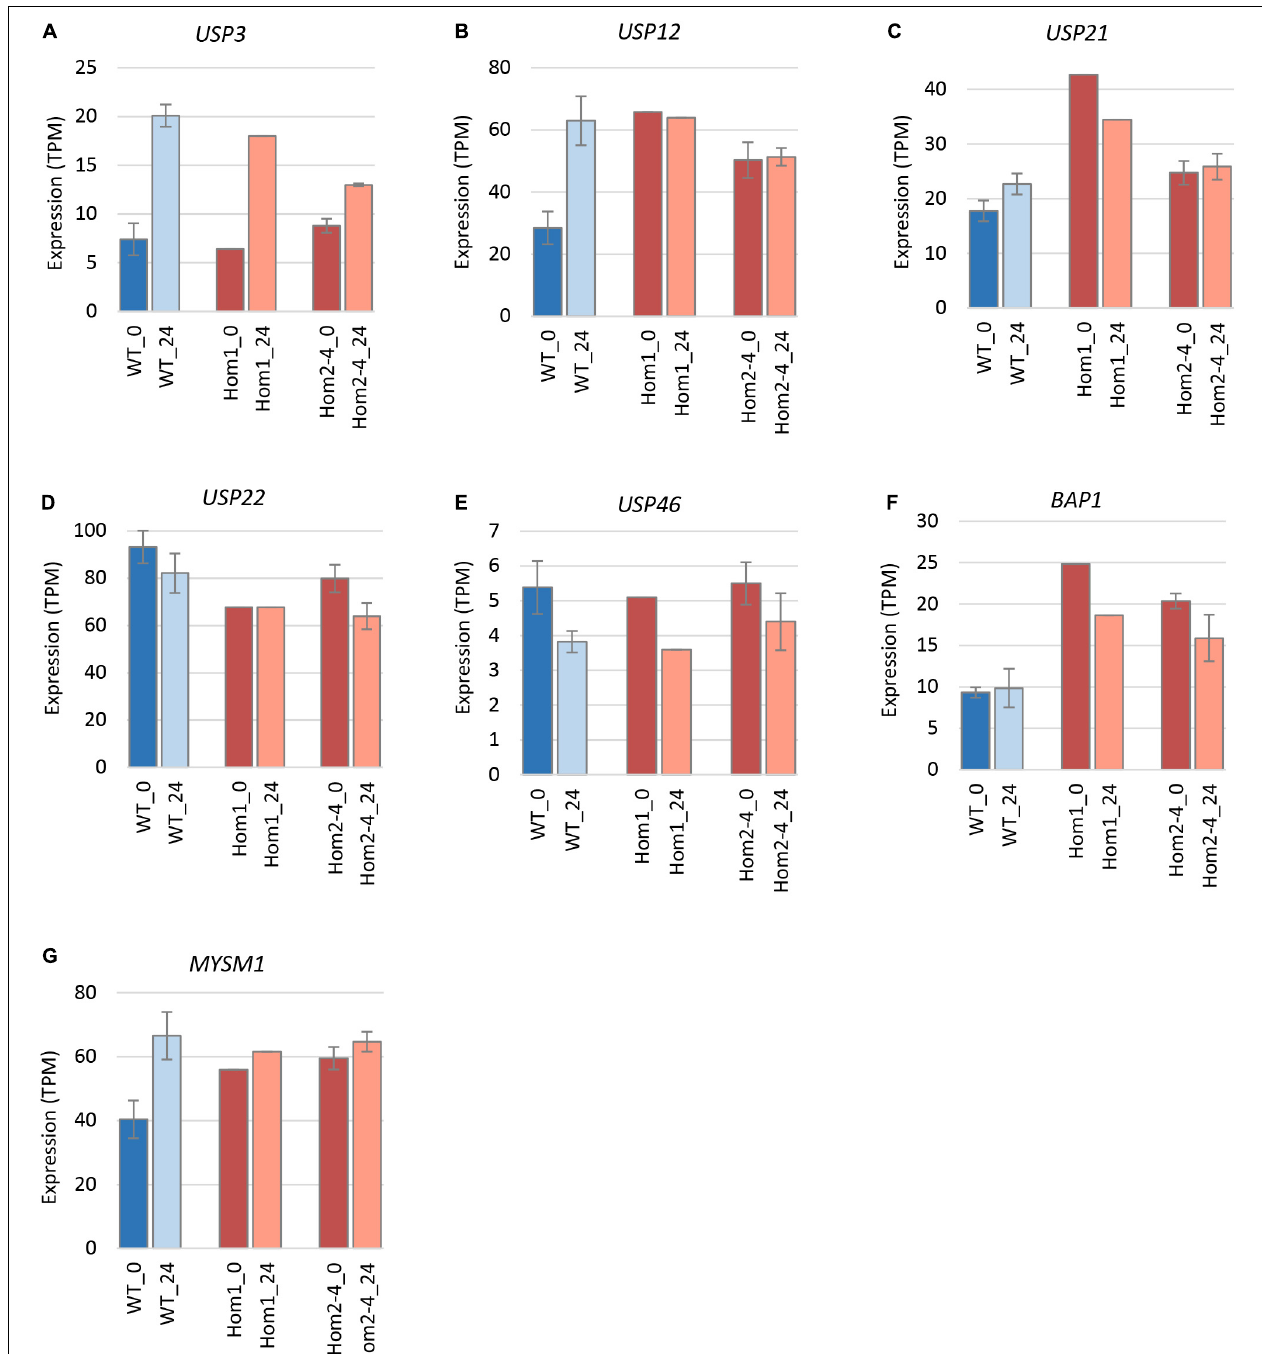
FIGURE 6 | Expression of deubiquitinase genes in edited clones. Results are based on expression levels extracted from CAGE data. Wild type samples are from Gazova et al. (2020). Results for wild type are the mean of 6 (0 h time point) and 4 (24 h time point) replicates. Results for Hom2, Hom3, and Hom4 were averaged. Standard error is shown by the bars. Significance of differences between genotypes can be seen in Table 2 . (A) Expression of USP3 . (B) Expression of USP12 . (C) Expression of USP21 . (D) Expression of USP22 . (E) Expression of USP46 . (F) Expression of BAP1 . (G) Expression of MYSM1 .